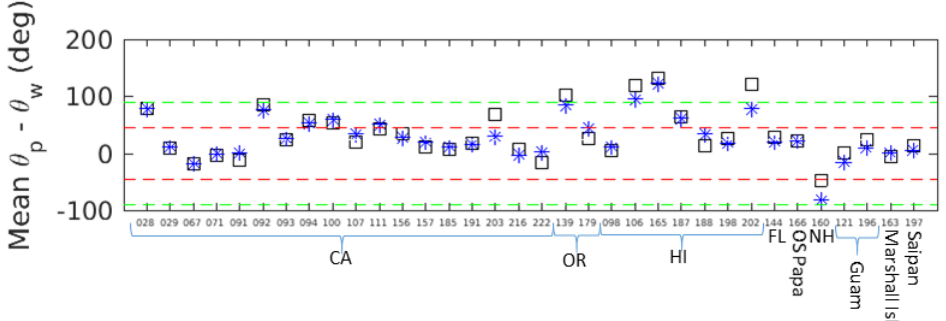
Figure 13. Average di ff erences between wave peak direction ( θ p ) and wind direction ( θ w ) for rogue event and non-rogue cases. Rogue event data are depicted by black squares, and non-rogue data are shown as blue asterisks. Red dashed lines mark ± 45 ◦ . Green dashed lines mark ± 90 ◦ .